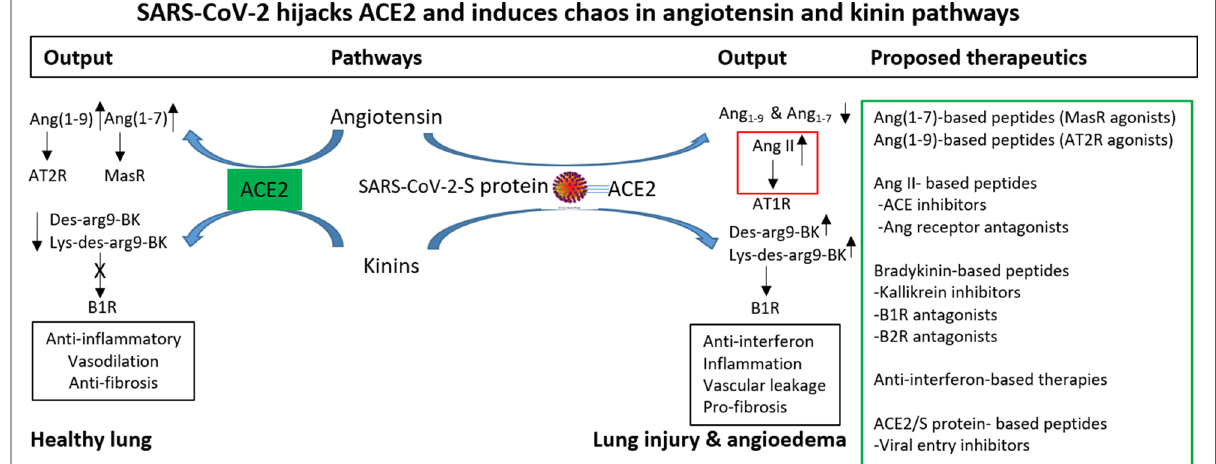
Fig. 1 ACE2 is a key enzyme in the RAS, catalyzing the metabolism of Ang II to Ang(1-7) and Ang I to Ang(1-9). ACE2 also mediates degradation of ACE-catalyzed breakdown products, Des-arg9-Bk (B1R agonist) and Lys-des-arg9-Bk. The net result of ACE2 in these two systems is to counterbalance ACE/Ang II/AT1R and Bradykinin/Des-arg9-Bk/B1R pathways. Through its cellular binding and entry mechanisms, SARS-CoV-2 is proposed to result in a reduction of ACE2, leading to elevations in Ang I and II, and leading to AT1R stimulation, and Des-arg9-Bk leading to B1R stimulation thus exacerbating inflammation, vascular leakage, and pro-fibrotic events. Potential therapeutics include those targeted to angiotensin and bradykinin system related peptides, in addition to peptides targeting the ACE2-viral spike (S) protein